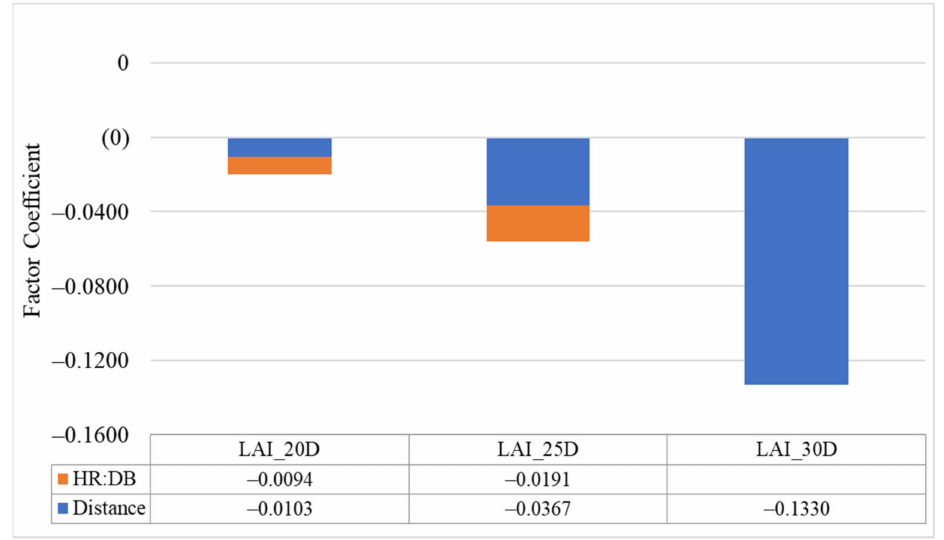
Figure 5. Coefficients of the significant factors for statistically reliable models associated to LAI. The associated error is equal to